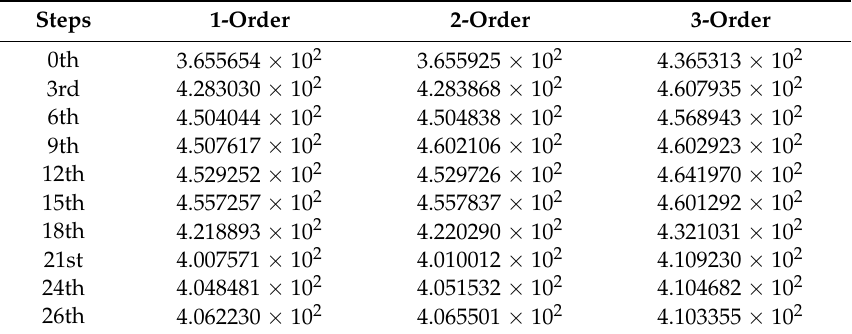
Table 3. The optimized material mechanism flexibility parameters in iterations.